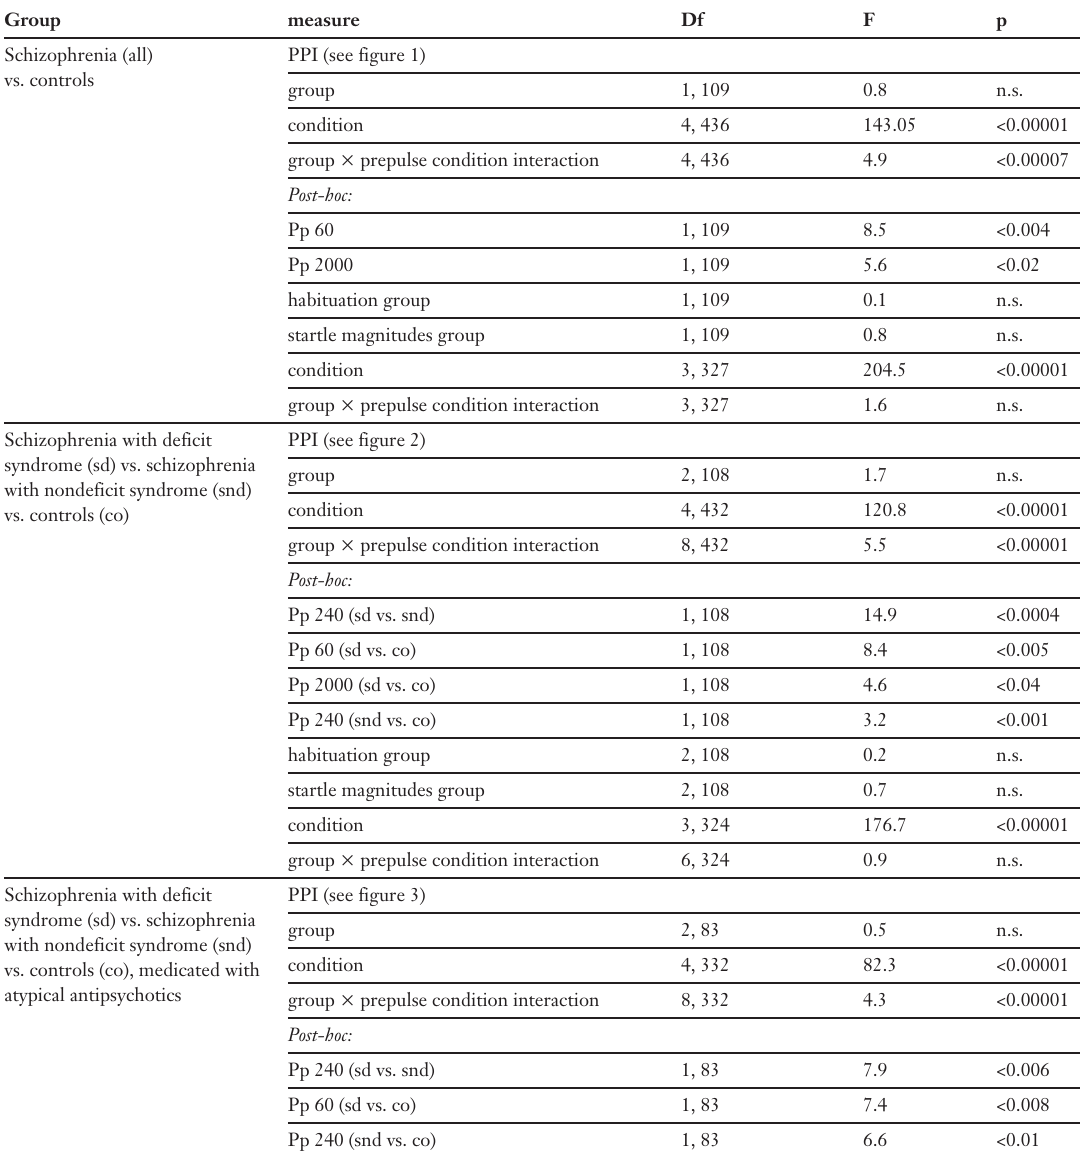
Statistical analyses –